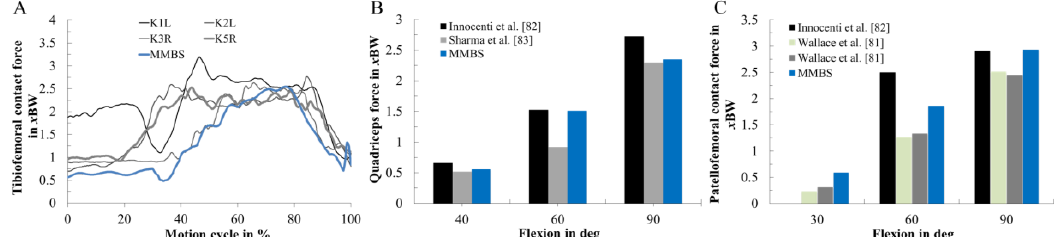
Figure A1. Validation of the musculoskeletal multibody simulation (MMBS) model. The MMBS model has been validated in terms of the tibiofemoral contact force ( A ), quadriceps force ( B ) and the patellofemoral contact force ( C ) during a dynamic squat motion. The tibiofemoral contact force is compared against the in vivo measurements of instrumented total knee replacements for three subjects (K1L, K2L, K3R, and K5R) [84]. The quadriceps force is compared against two simulation studies [82,83]. The resultant patellofemoral contact force is an important validation parameter for patellofemoral joint dynamics: it is compared against studies described in